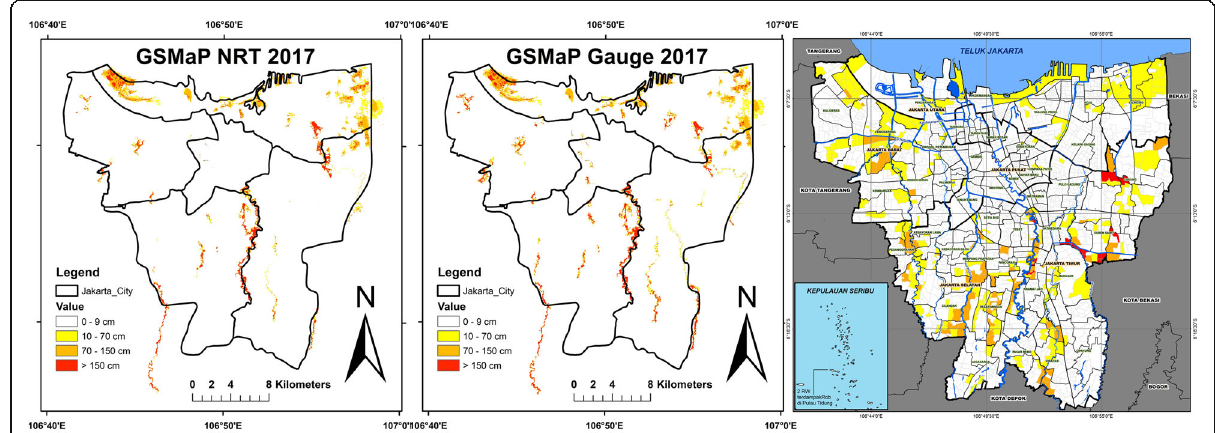
Fig. 14 Flood inundation comparisons for flood event of 2017